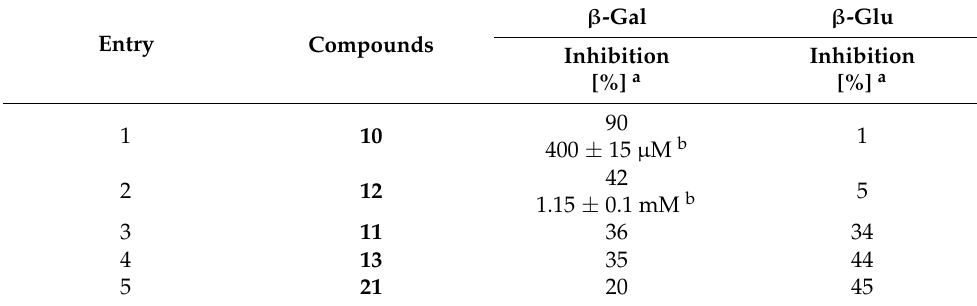
Table 2. β -Gal and GCase ( β -Glu) inhibition in human leukocytes from healthy donors.